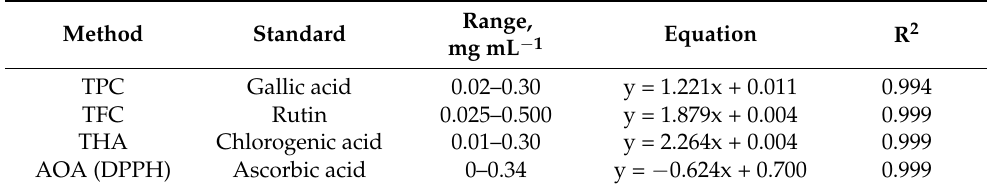
Table A1. Calibration curves of the equation of phenolic compound standards.